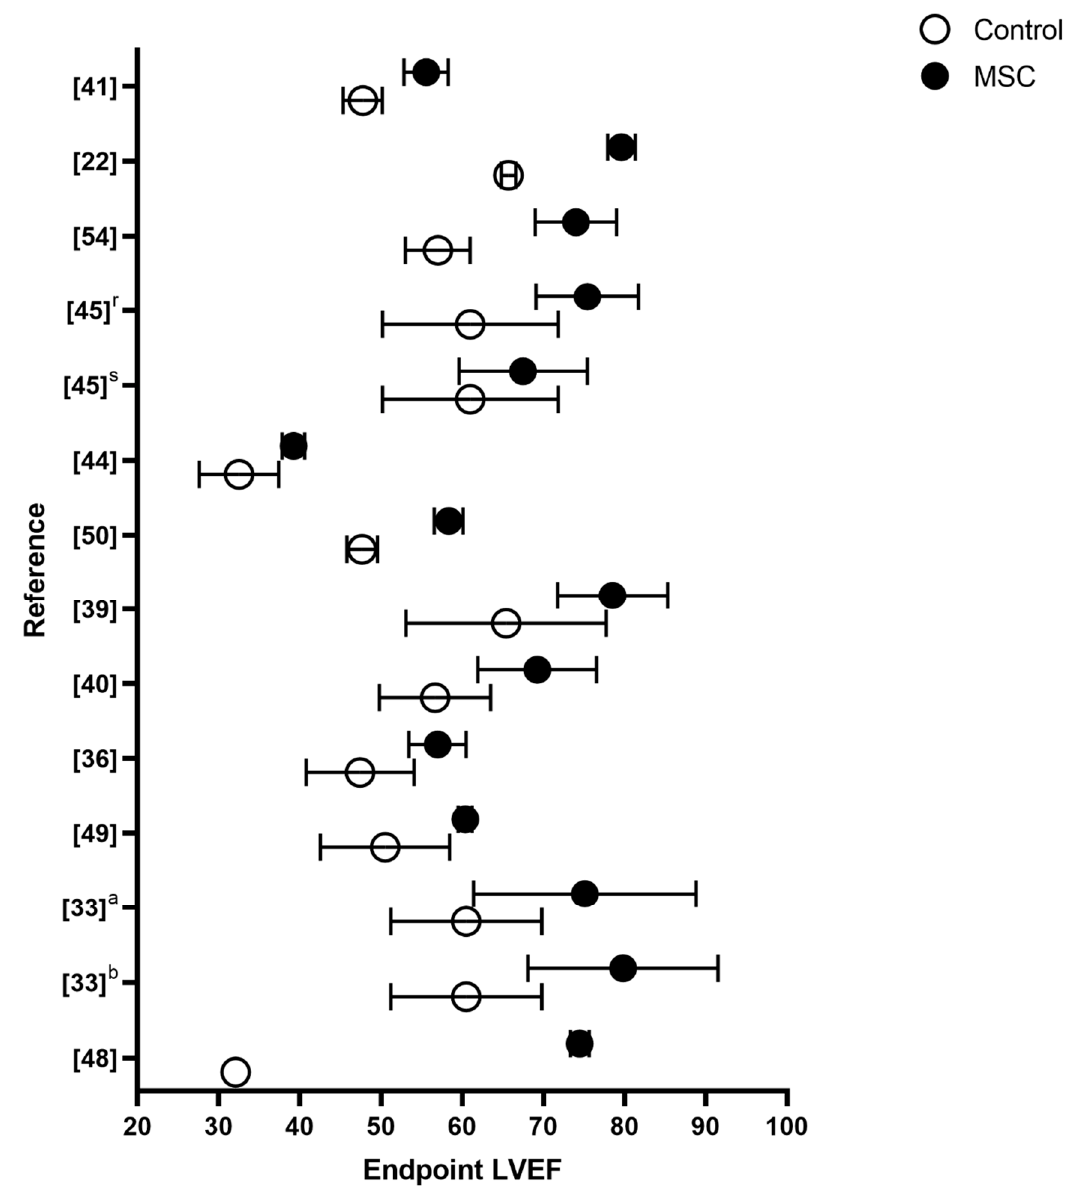
Figure 2. Overview of LVEF values for each preclinical study providing numerical endpoint LVEF values. The preclinical studies not reporting on this are not included in the figure. The y-axis is presented with reference number. Additionally, r is repeated injections, s single injection, a AT-MSCs and b BM-MSCs. Data from both MSC and control croup is presented as LVEF mean with standard deviations.